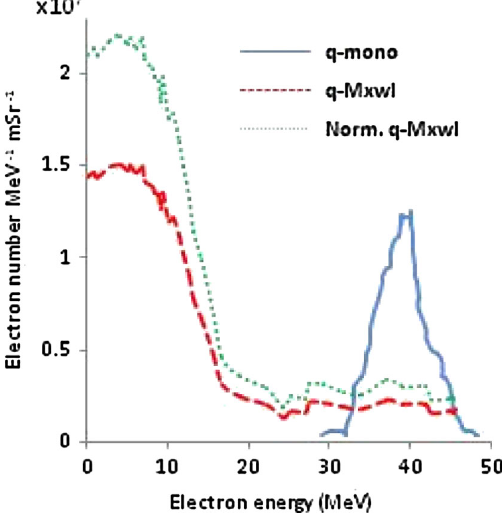
FIG. 2. The experimental electron distributions including the q -monoenergetic (blue continued line), the q -Maxwellian (red dashed line), and its normalized (green dotted line) plots are